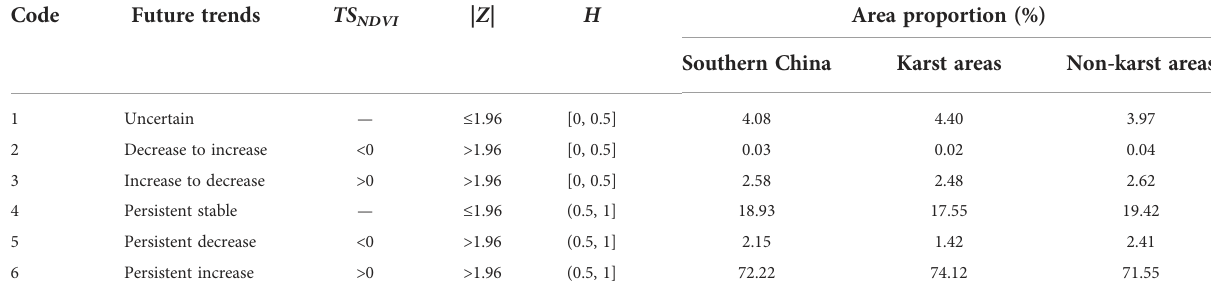
TABLE 2 Area ratio of different future vegetation change trend types based on the Theil-Sen trend slope ( TS NDVI ), Mann-Kendall test (| Z |) and Hurst exponent ( H ).